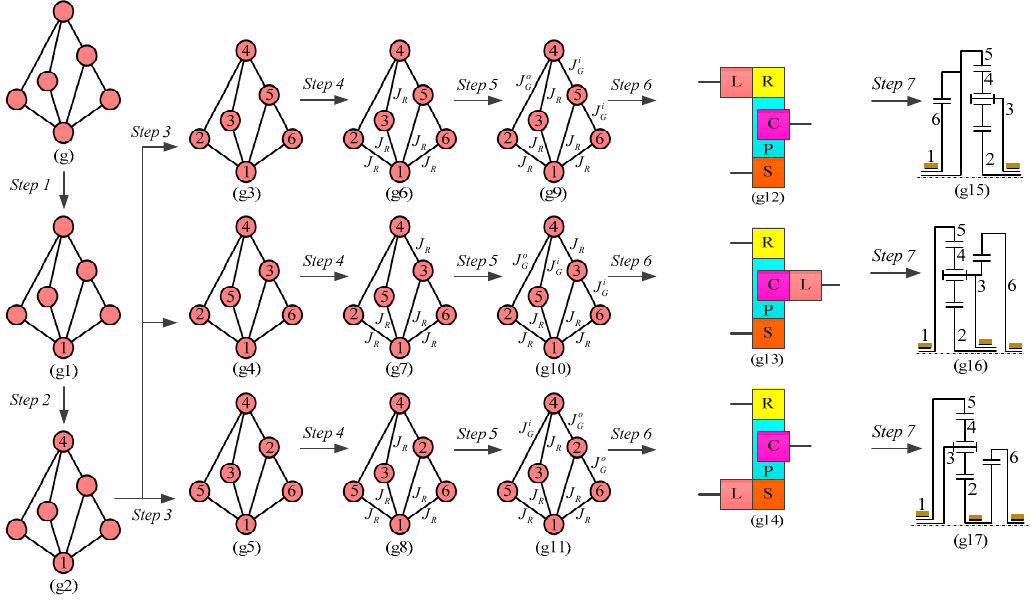
Figure 5. Process of specialization.